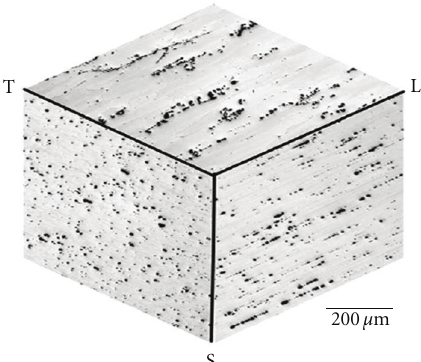
Figure 4: Three optical micrographs of the perpendicular faces of a typical specimen of 7075-T6 aluminum